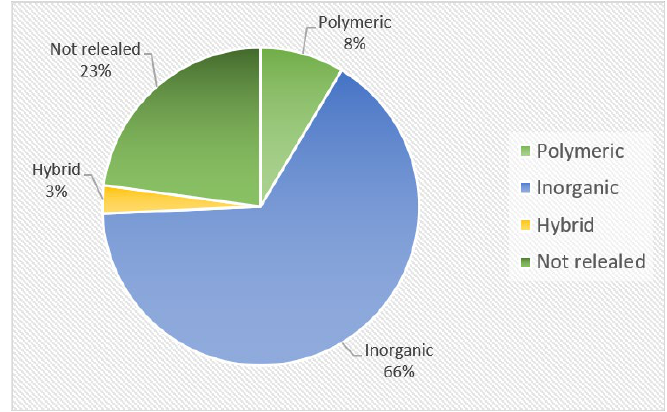
Figure 14. Classification of ASSBs based on the material used in the fabrication of SSE.